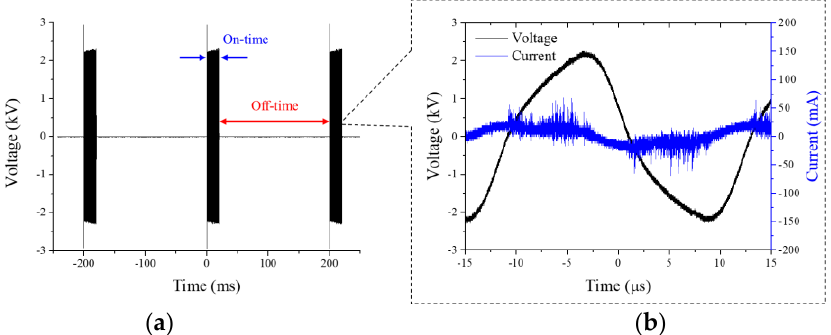
Figure 1. ( a ) Duty ratio of applied voltage, ( b ) voltage (black line) and discharge current (blue line) versus time.